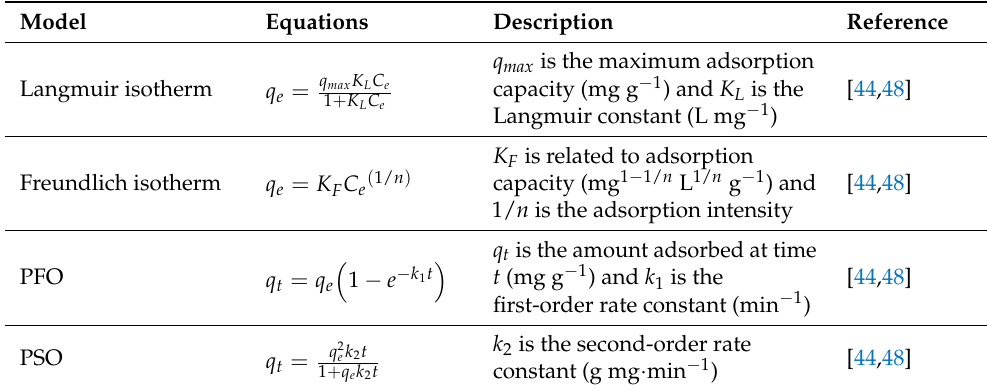
Table 7. Nonlinear equations of Langmuir and Freundlich isotherms, PFO and PSO kinetic models.